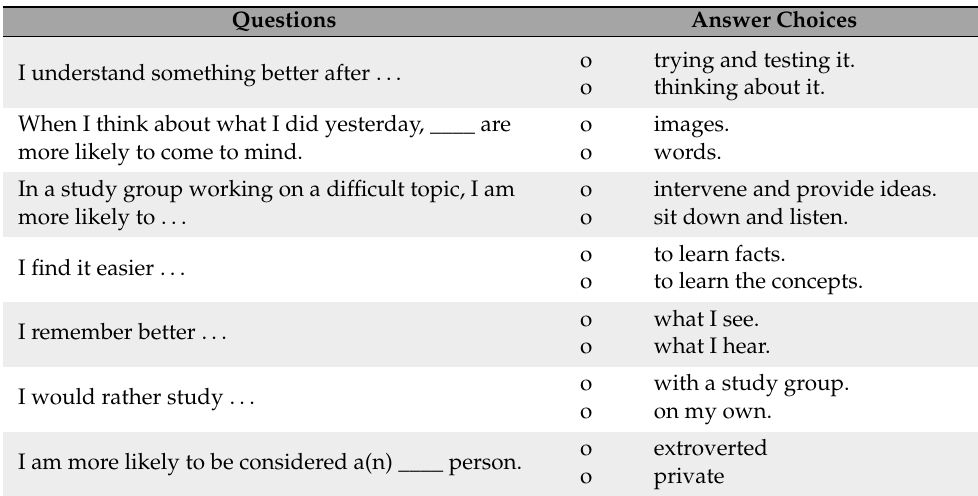
Table 5. Example of questions from the learning styles test [23].